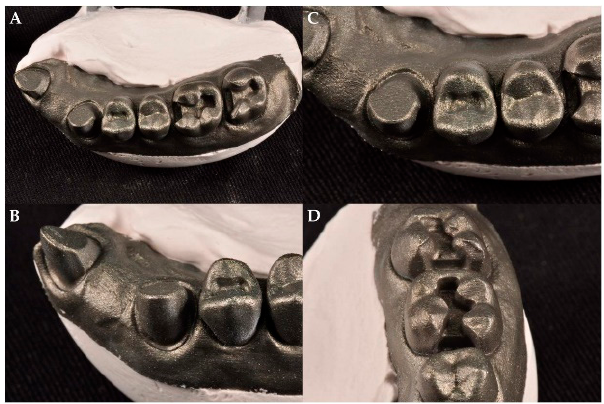
Figure 1. ( A ) 3-dimensional (3D) printed right maxillary quadrant Co-Cr typodont model, ( B ) Complete coverage crown preparation on maxillary canine (MxC#13), ( C ) Occlusal inlay preparation